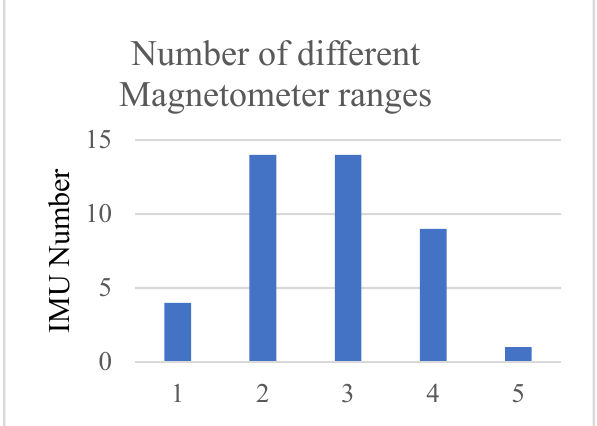
Figure 6. The different ranges of